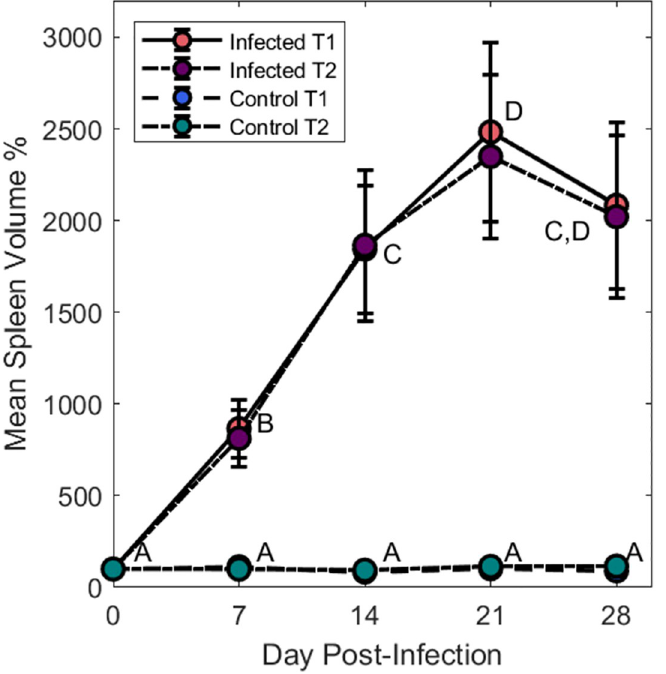
Fig 3. Comparison of spleen volume. Comparison of the mean spleen volumes demonstrates a large change in volume for the infected animals, with both T 1 and T 2 data shown. The mean spleen volume for the control groups using T 1 and T 2 are not significantly different (p > 0.05) and are overlayed. Spleen volume is shown as a percentage of the volume measured at day 0. Splenomegaly was apparent after day 0 pi with the peak increase in volume at day 21pi for the T 1 weighted data at 2483% of the original volume and 2349% for the T 2 weighted data. A significant (p < 0.05) stepwise increase can be seen following infection until day 21pi. All infected spleen volumes are significantly higher (p < 0.05) compared with their pre-infection states. The control group shows no significant change (p > 0.05, ~1% change in volume) over the time course of the experiment. The means of groups that do not share a letter are significantly different from each other (p <